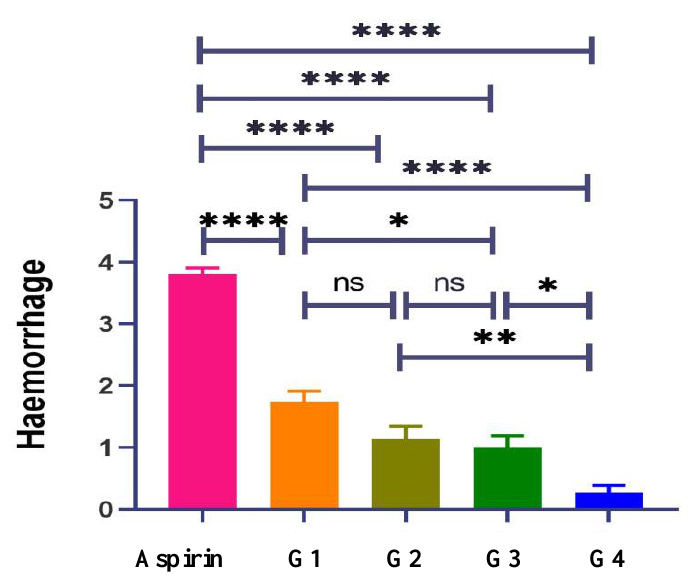
Figure 20. Hemorrhage score. Data were presented as means ± SE. *statistically significant at p ≤ 0.1, ** p ≤ 0.01, **** p ≤ 0.0001. Significance was considered at p ˂ 0.05. ns-not significant.